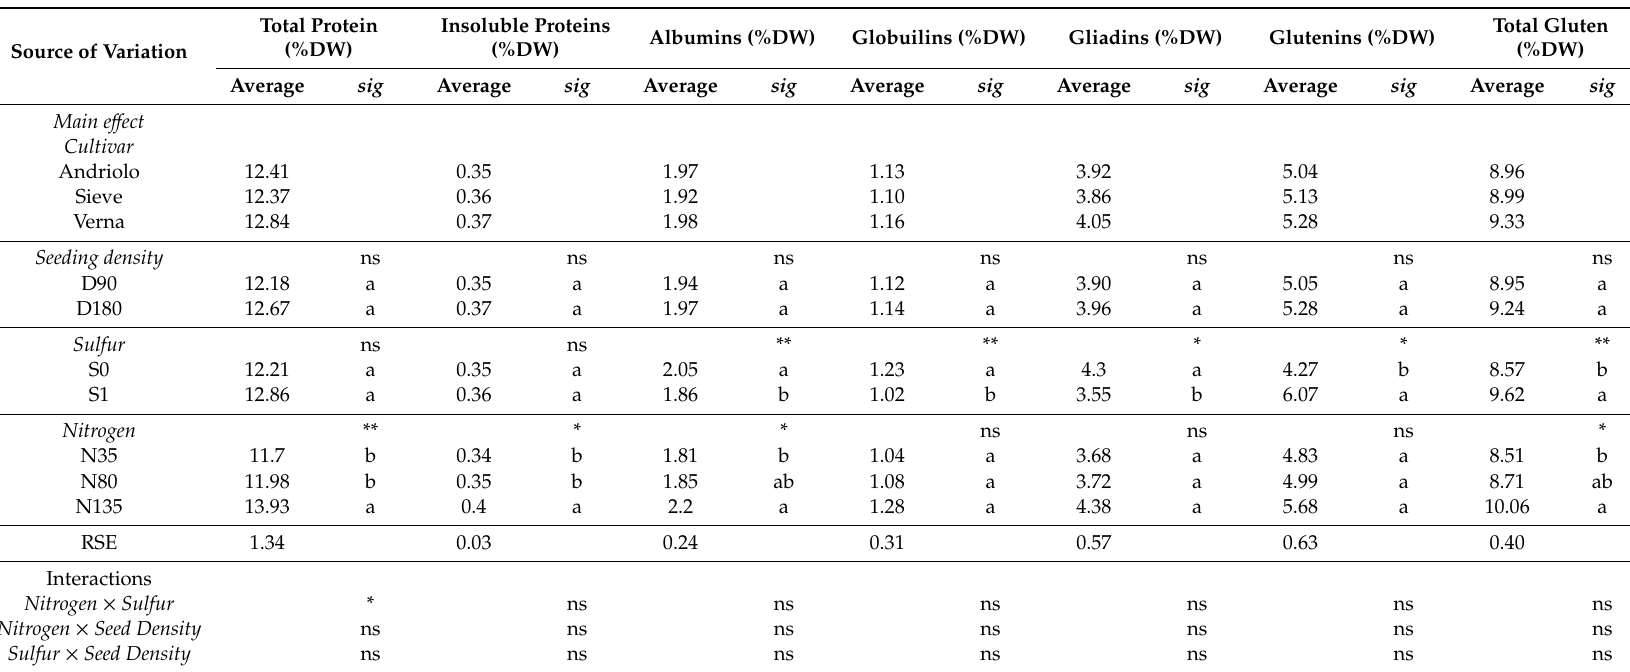
Table 2. Mean of kernel protein fraction results by nitrogen fertilization, sulfur fertilization, seed density, cultivar and first order interaction. The sig columns report the ANOVA results (* = 0.05, ** = 0.01, *** = 0.001, ns = not significant), while lowercase letters represent the Tukey HSD post hoc test results. RSE = residual standard